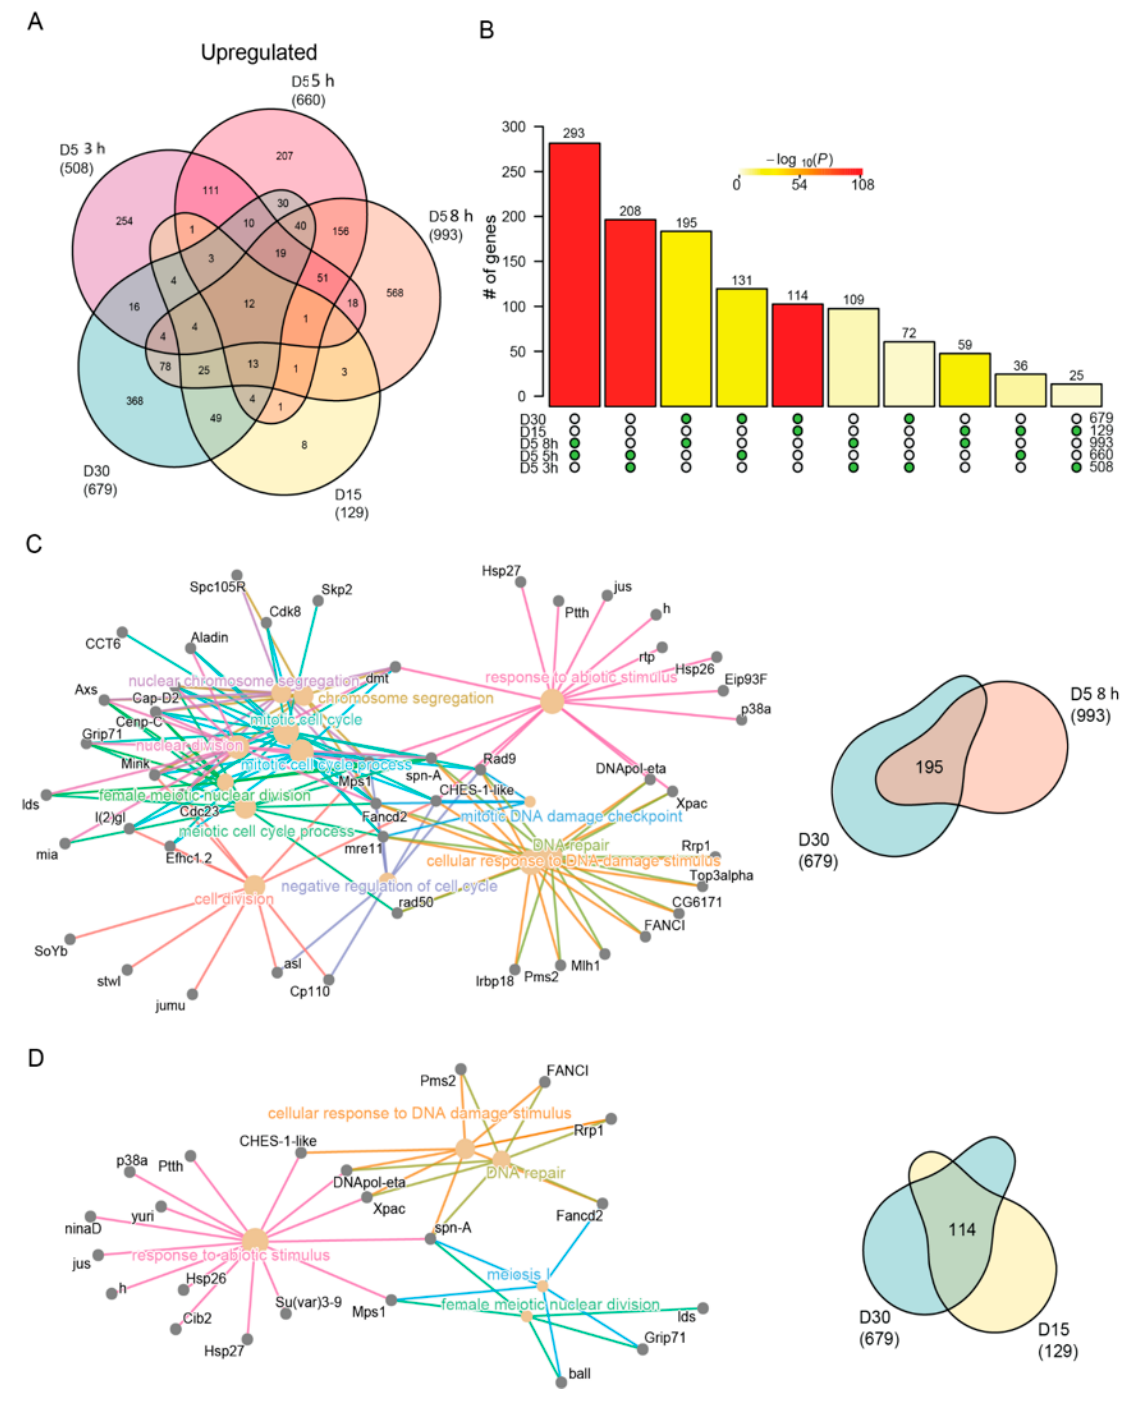
Figure 4. Similar stress response genes are induced with age and blue light stress. ( A ) Venn diagram of the differentially upregulated genes in aged or blue light exposed flies relative to D5. ( B ) Statistical analysis for all pairwise comparisons of significantly upregulated genes in aging or blue light exposed conditions. Bar height represents the number of genes in each pairwise overlap (green dots). Bars are colored by p -values from fisher’s exact test, with the null hypothesis being an overlap no greater than that expected by chance. Cnetplots representing the enriched GO terms and corresponding genes for the intersection between ( C ) 8 h and D30 or ( D ) D15 and D30 upregulated genes.